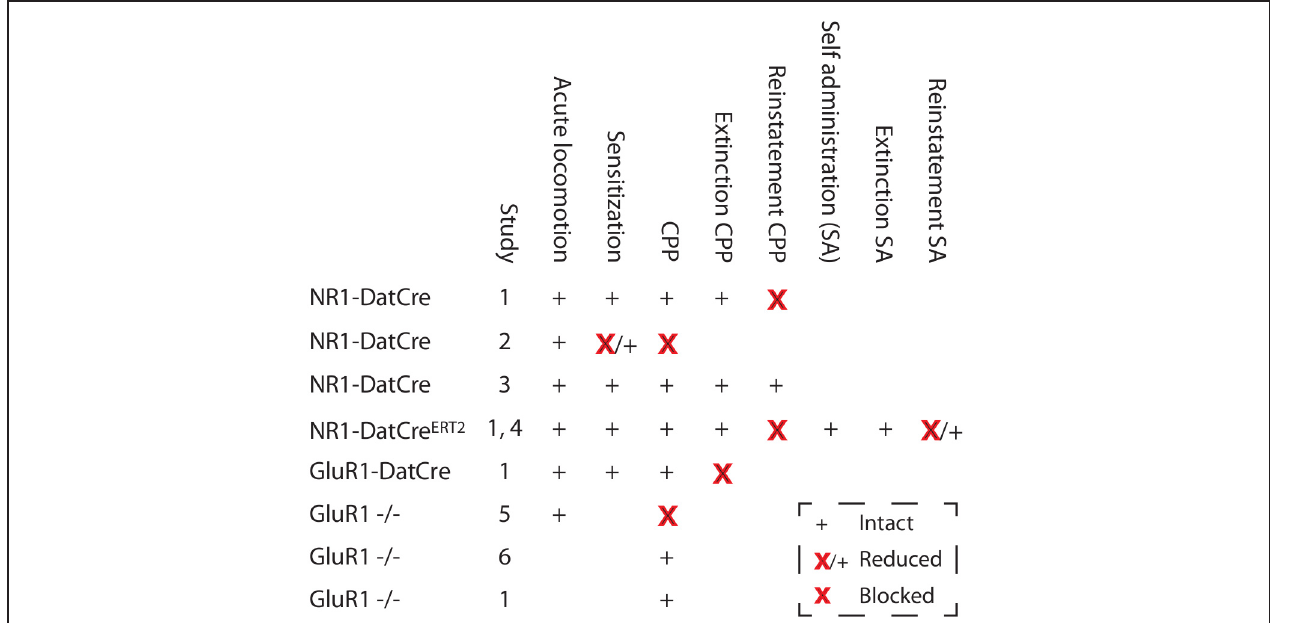
FIGURE 5 | Changes in cocaine-related behaviors in mice with deletions of NMDARs or GluR1. Studies: 1, Engblom et al. (2008); 2, Zweifel et al. (2008); 3, Luo et al. (2010); 4, Mameli et al. (2009); 5, Dong et al. (2004); and 6, Mead et al. (2005). SA, Self